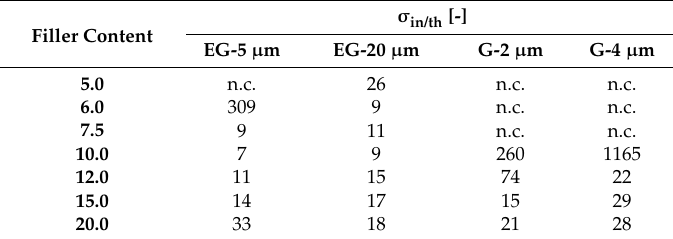
Table 2. Quotient of in-/through-plane σ values ( σ in/th ) of PVDF/G and EG composites, measured in two directions on compression molded